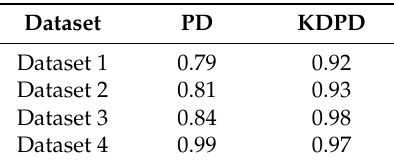
Figure 11. Receiver operating characteristic (ROC) curves of the four datasets including each fault type. Table 2. Area under the ROC (AUROC) (If AUROC = 1, then the test is perfect. If AUROC = 0.5, then the test is worthless) 1 .